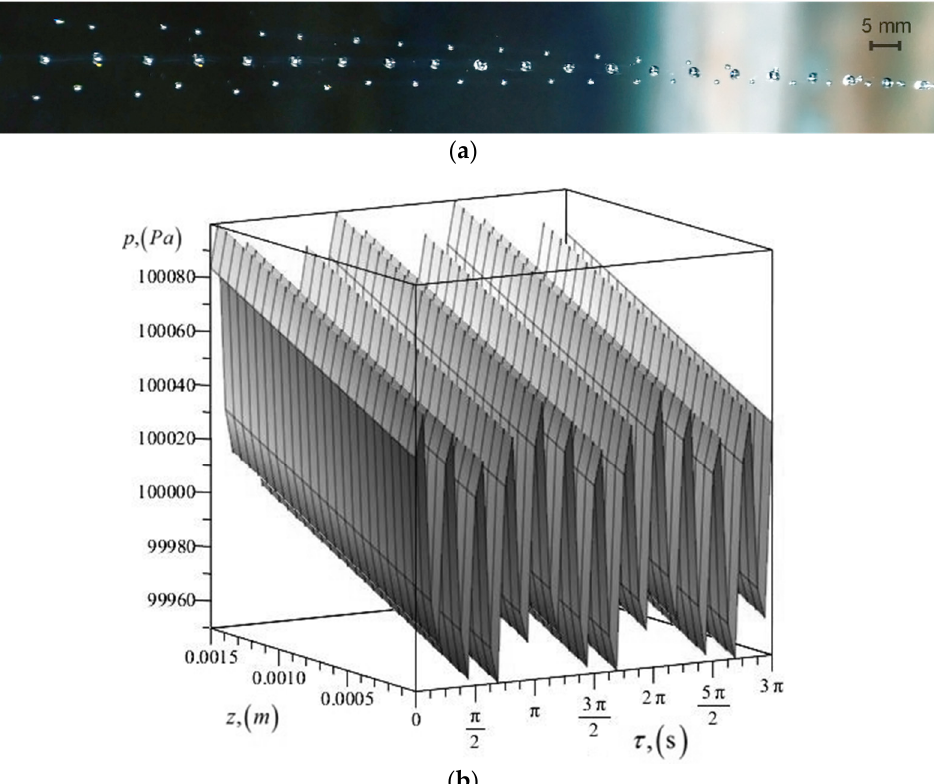
Figure 5. Comparison between jet disintegration at the signal frequency of 800 Hz, and amplitude of 50 μ m: ( a ) physical experiment; ( b ) theoretical calculation using Equation (8).